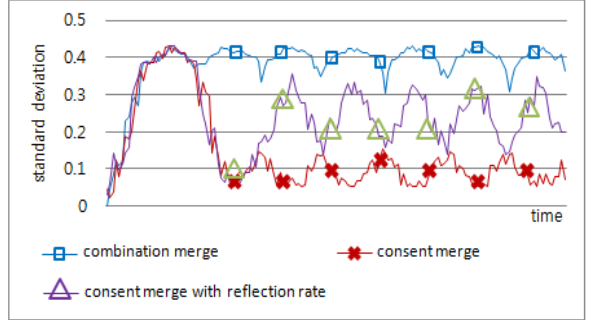
Fig. 5. The standard deviation of the confidence